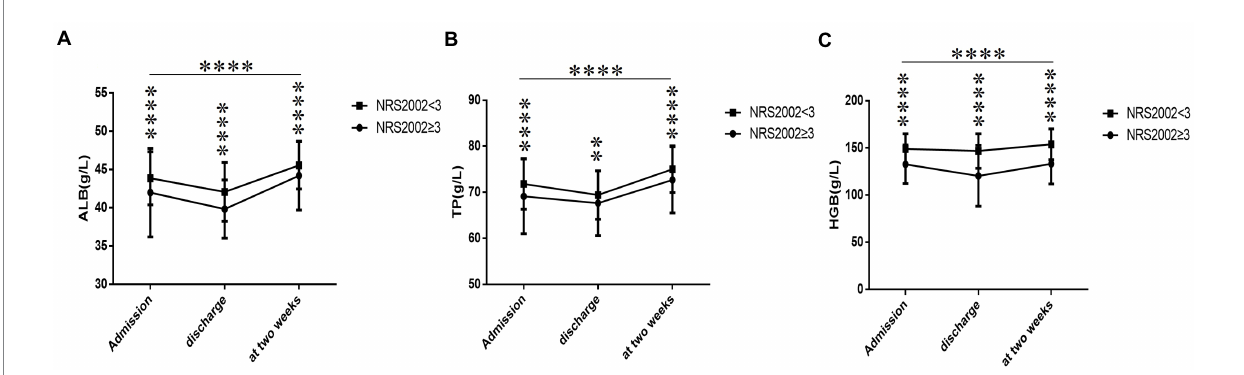
FIGURE 2 Comparison of ALB, TP and HGB between NRS2002 ≥ 3 group and NRS2002 < 3 group within 2 weeks ( n = 1187; NRS2002 ≥ 3 and NRS2002 < 3 groups, n = 92 and 1095, respectively). ALB, albumin; TP, total protein; HGB, hemoglobin. (A) ALB. (B) TP. (C) HGB. All variables were presented as